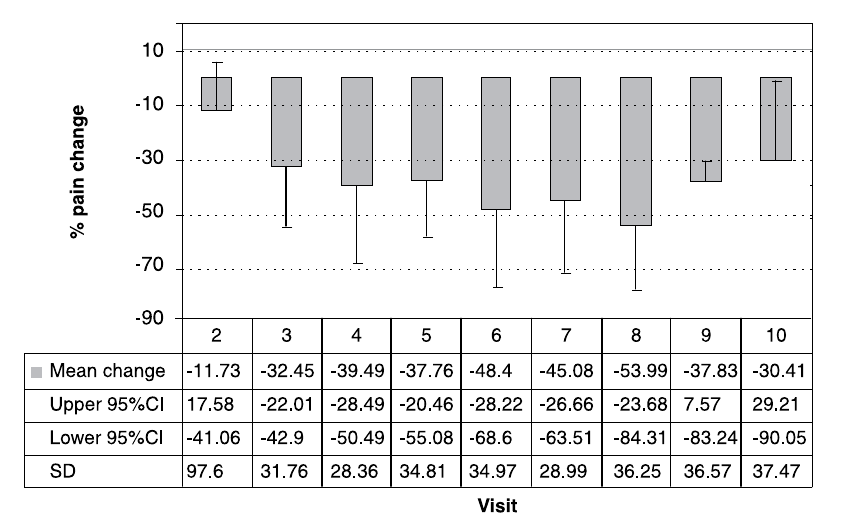
Figure 2: Mean pain change (% change) between day of treatment and previous day